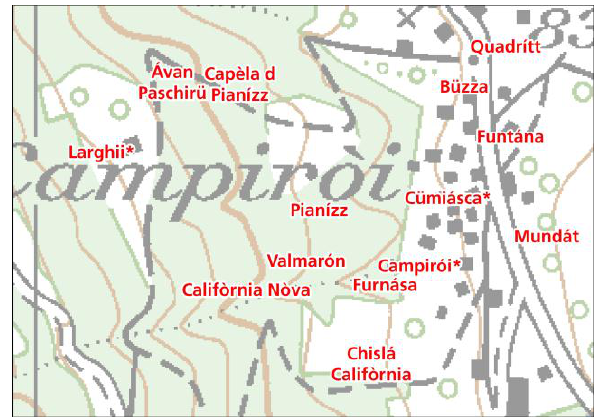
Figure 3: On a 1:25.000 map the localization of place names is far from being self-intelligible for normal people who are not familiar in reading and orienting maps and may fail in giving precise information. (© Swisstopo)